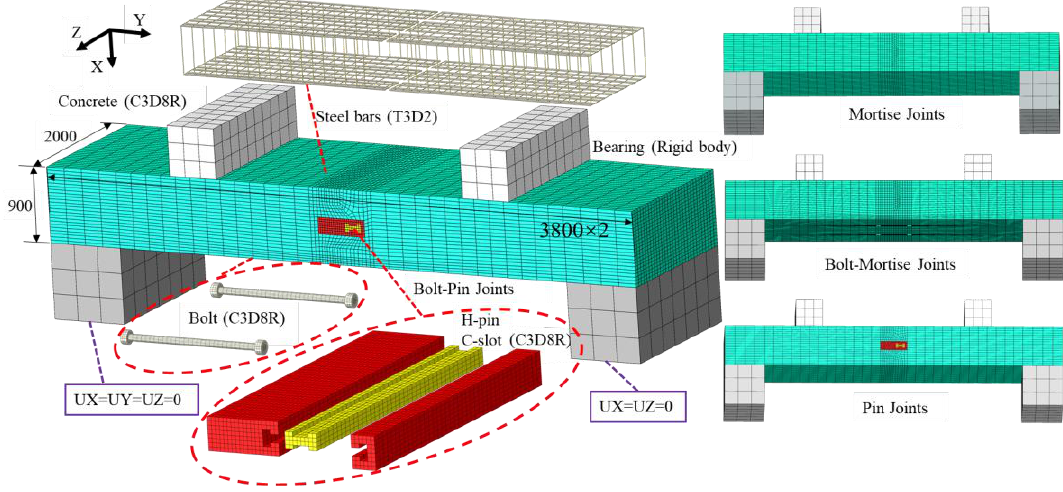
Figure 3. Model mesh (dimensions in mm).